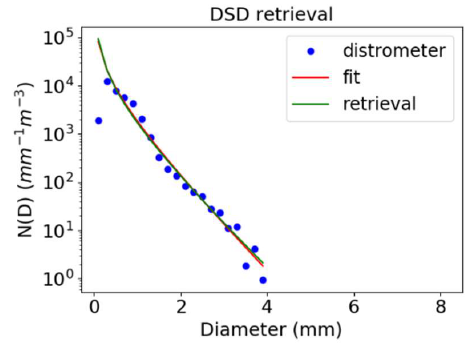
Figure 7. An example of DSD retrieval for illustration of the difference between the real DSD and Gamma model. The blue dots are the DSD observed by the disdrometer at 02:05 UTC on 27 August 2006. The red curve is the Gamma fit for the disdrometer data with the truncated moment method. The green curve is the DSD retrieved by the nearest neighborhood method.